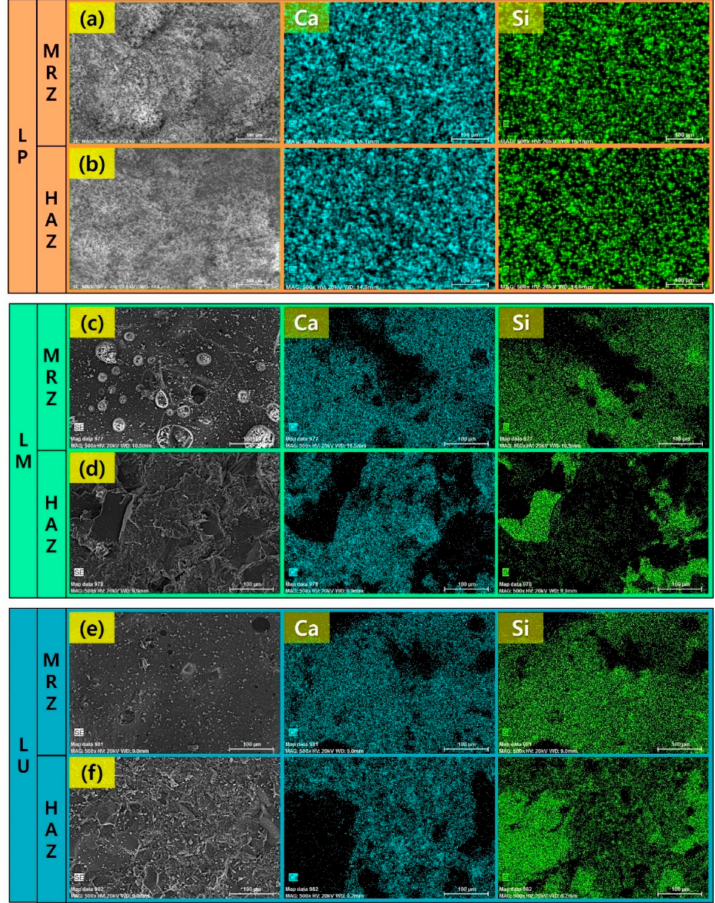
Figure 6. Elemental mapping for Ca and Al on the specimens after the laser cutting: ( a ) MRZ of LP; ( b ) HAZ of LP; ( c ) MRZ of LM; ( d ) HAZ of LM; ( e ) MRZ of LU; and ( f ) HAZ of